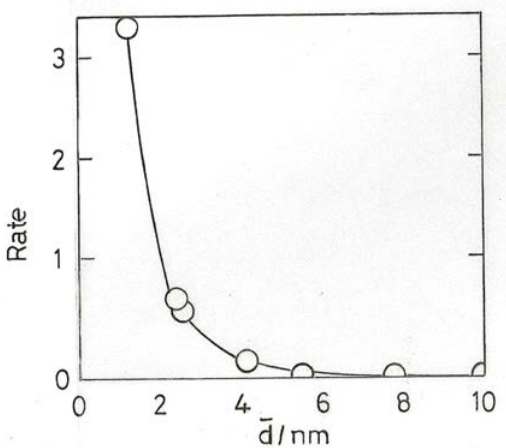
+ D equilibration (10 18 molecules s − 1 ) on Au/TiO 2 2